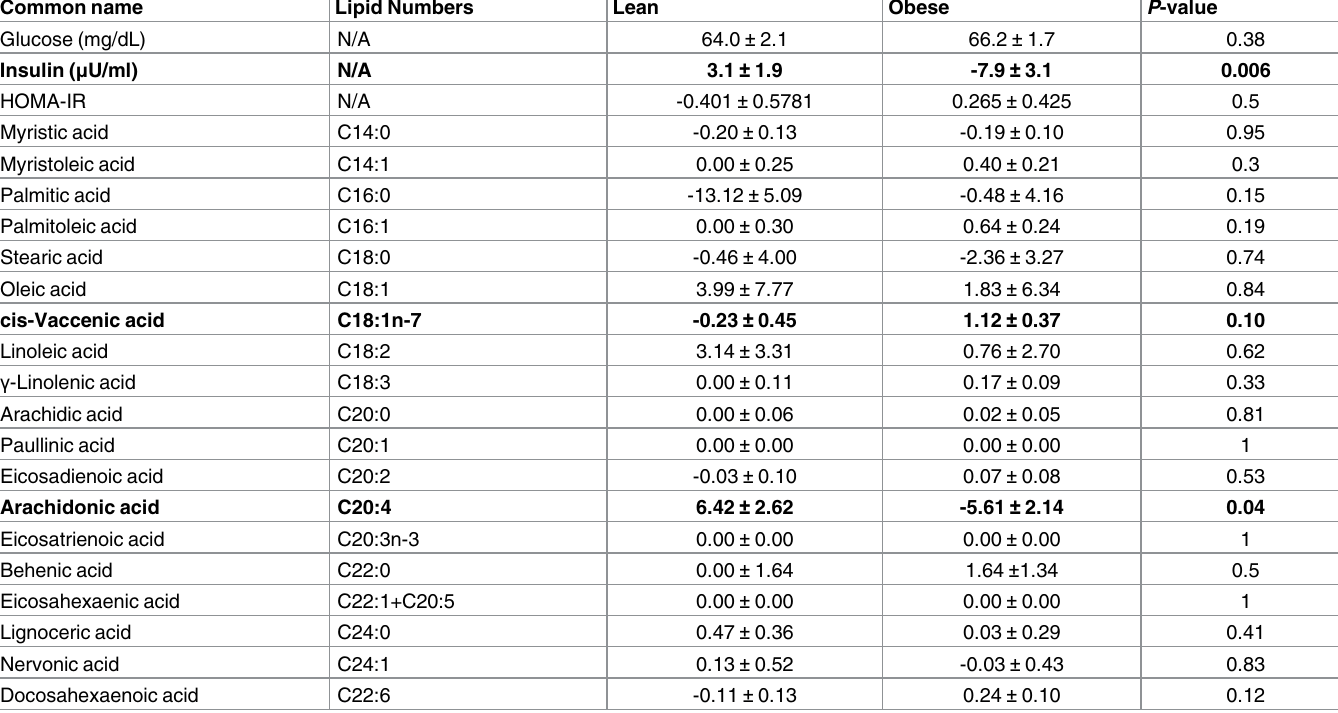
Table 2. Averageglucose concentration and change in insulin, HOMA-IR, and free fatty acids from beginning to end of trial for lean and obese